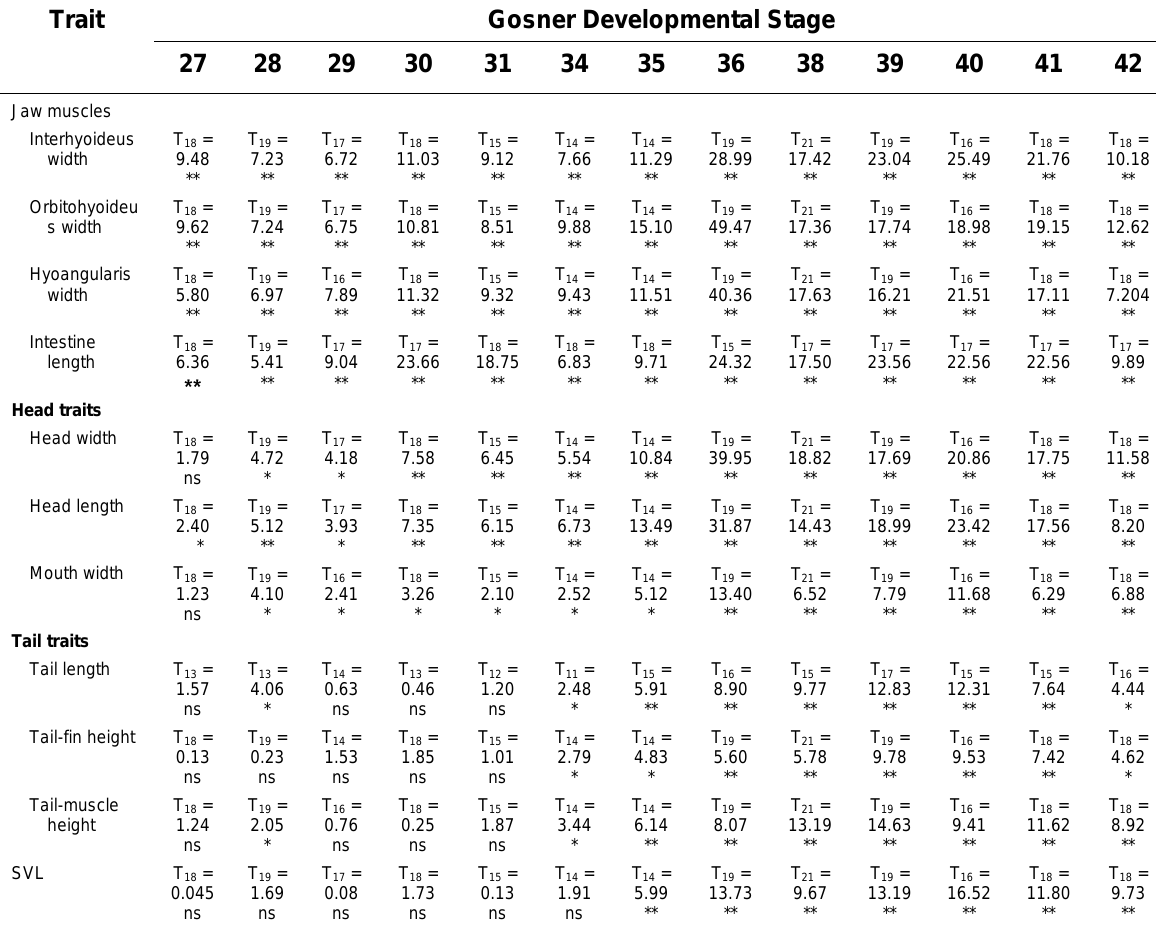
T -Test of Log (Base 10)-Transformed Trait Measurements at Each Gosner Developmental